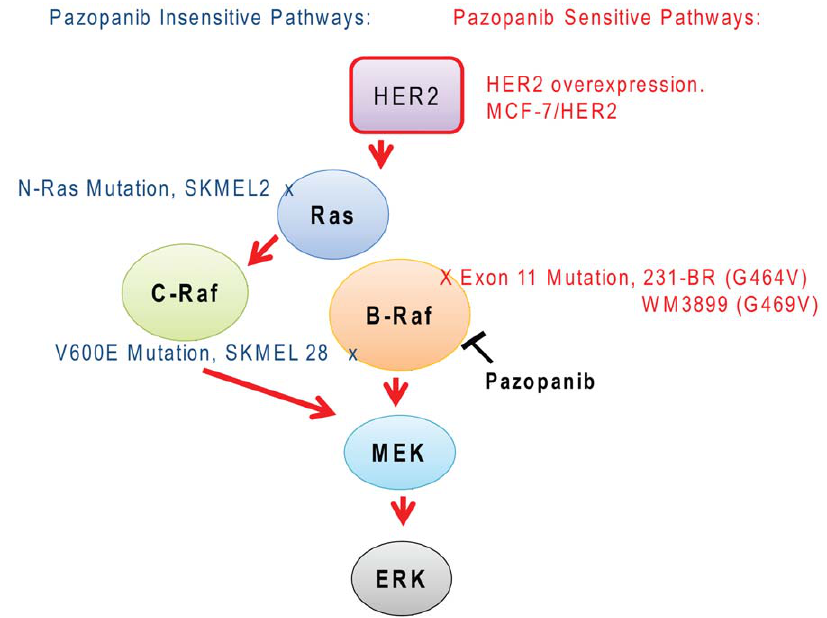
Figure 6. Schematic of pazopanib signaling pathways. The standard receptor tyrosine kinase activation of the ERK pathway is shown. Pazopanib sensitive alterations, including HER2 overexpression and B-Raf exon 11 mutations, are shown on the right in red. Insensitive alterations are shown on the left in blue. Tumor cell lines featuring each alteration are named.